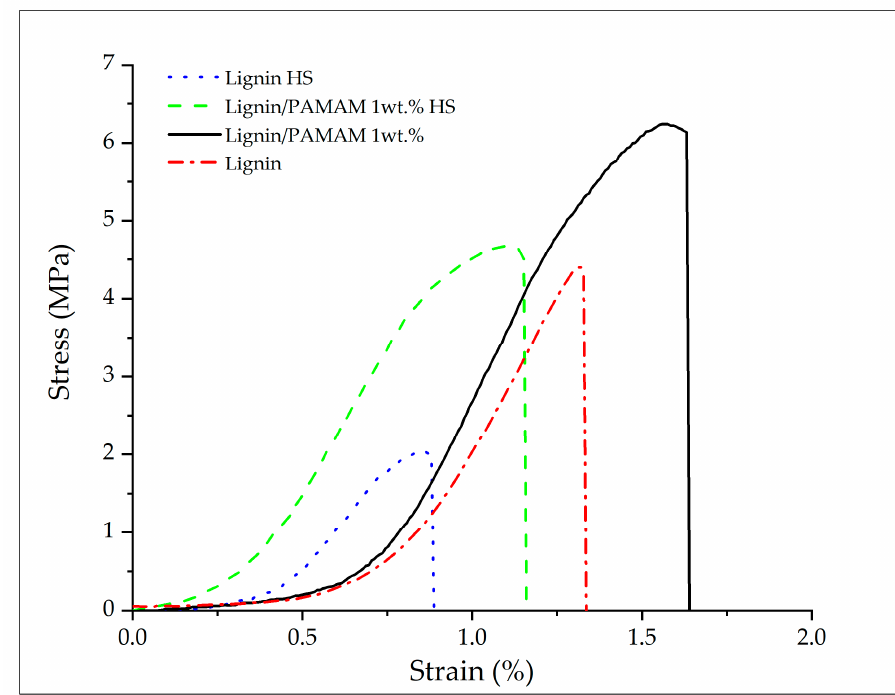
Figure 4. Sample stress-strain response of lignin and lignin/PAMAM electrospun mates before and after heat-setting procedure. Very slight fiber slippage was observed in the beginning of deformation. The vertical lines indicate the breakage onset (material failure) in each of the tests.